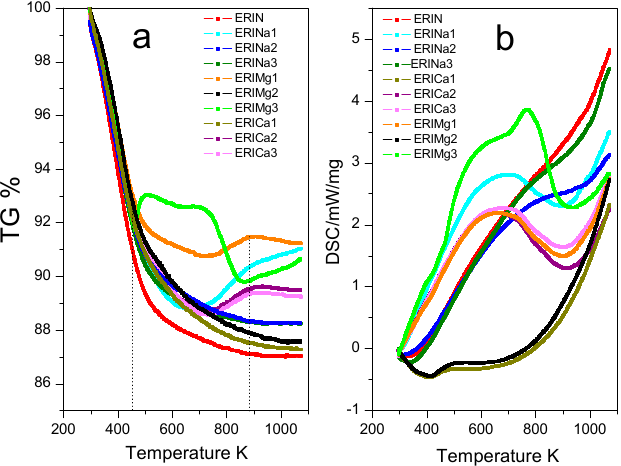
Figure 5. ( a ) Thermogravimetric analysis (TGA) and ( b ) Differential scanning calorimetry (DSC) of erionite zeolites.